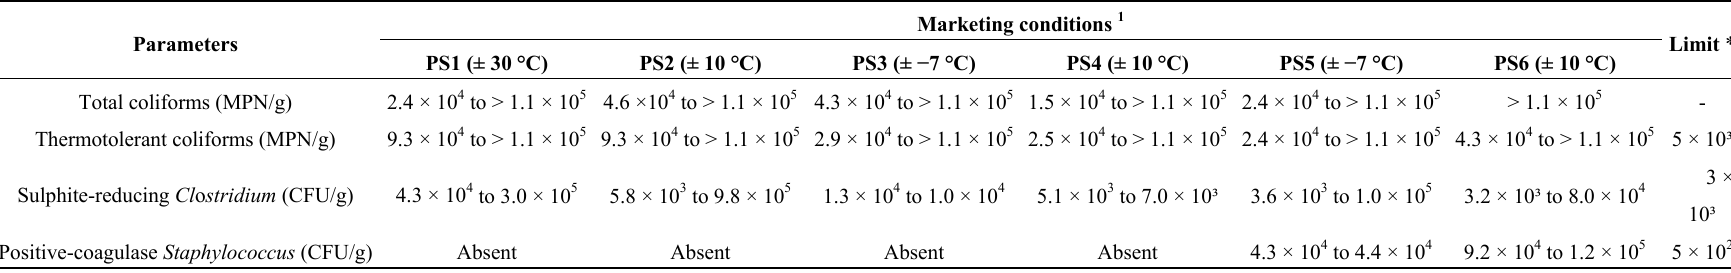
Table 1. Microbiological quality of goat “sarapatel” samples marketed under different storage conditions (results expressed as minimum and maximum value for each storage condition).